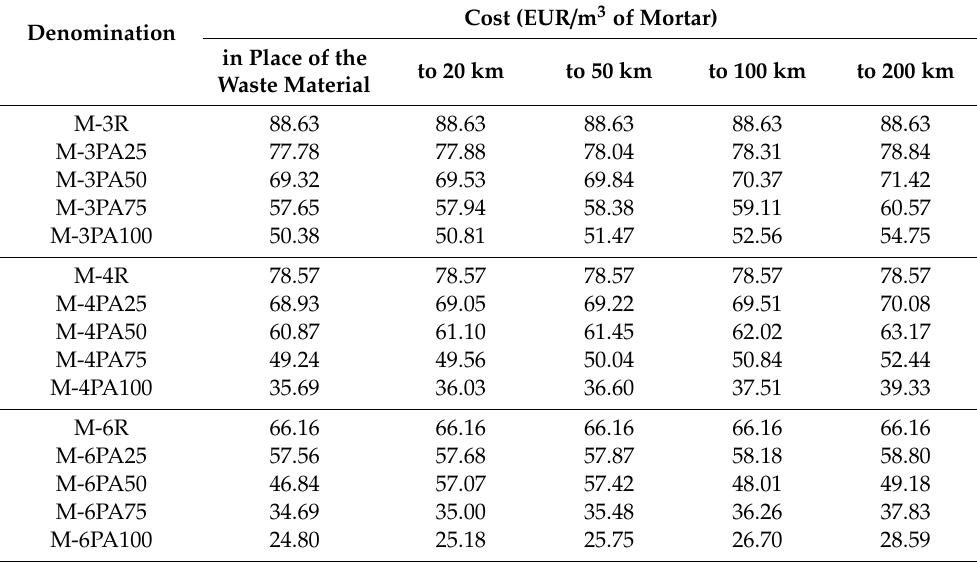
Table 14. Cost for each of the mortar denominations considering various distance for transporting the polyamide powder waste to the mortar production